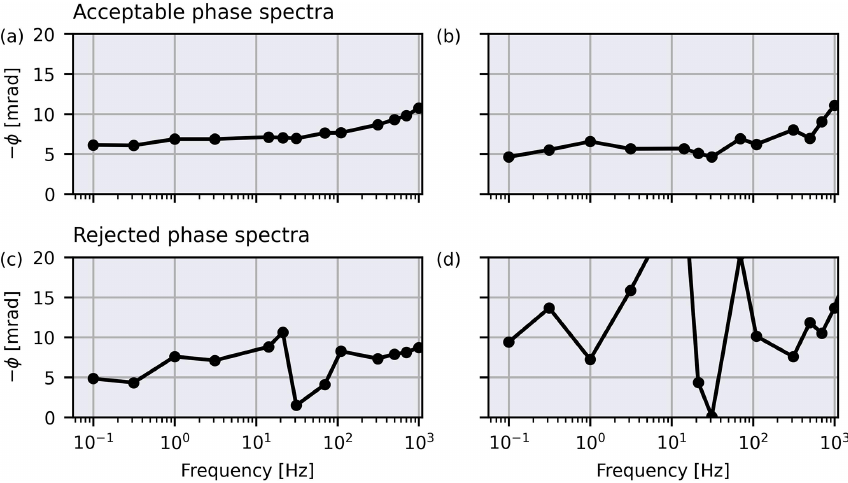
Figure 5. (a, b) Examples of phase spectra that were deemed acceptable for further use with regard to the smoothness criterion. (c, d) Examples of phase spectra that violate the smoothness criterion. Note that the measurements at 50 and 110Hz were already removed.